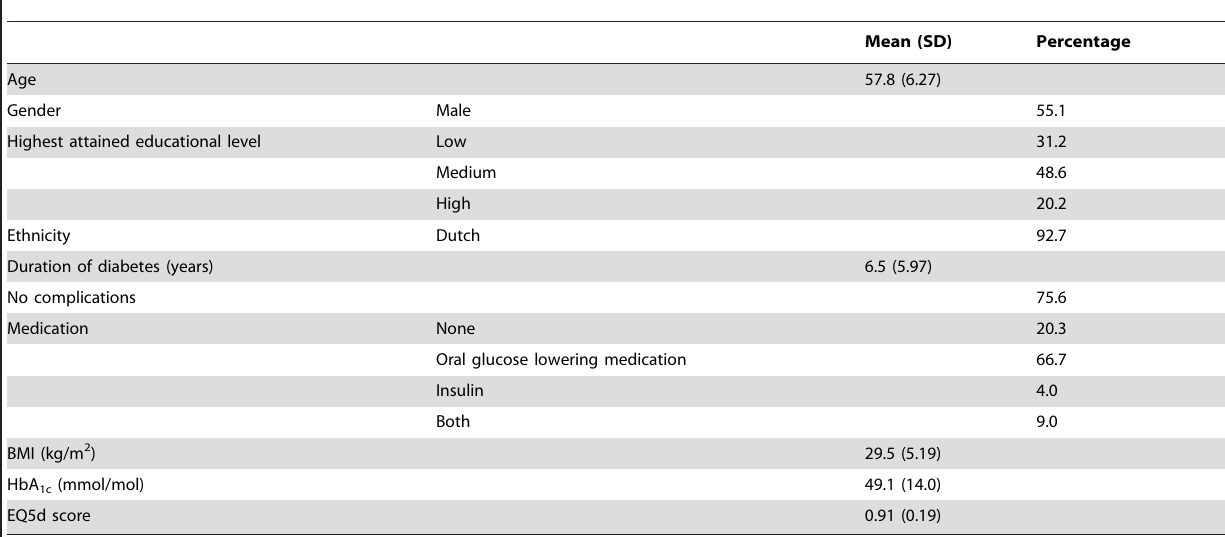
Table 2. General description of the study population (N=